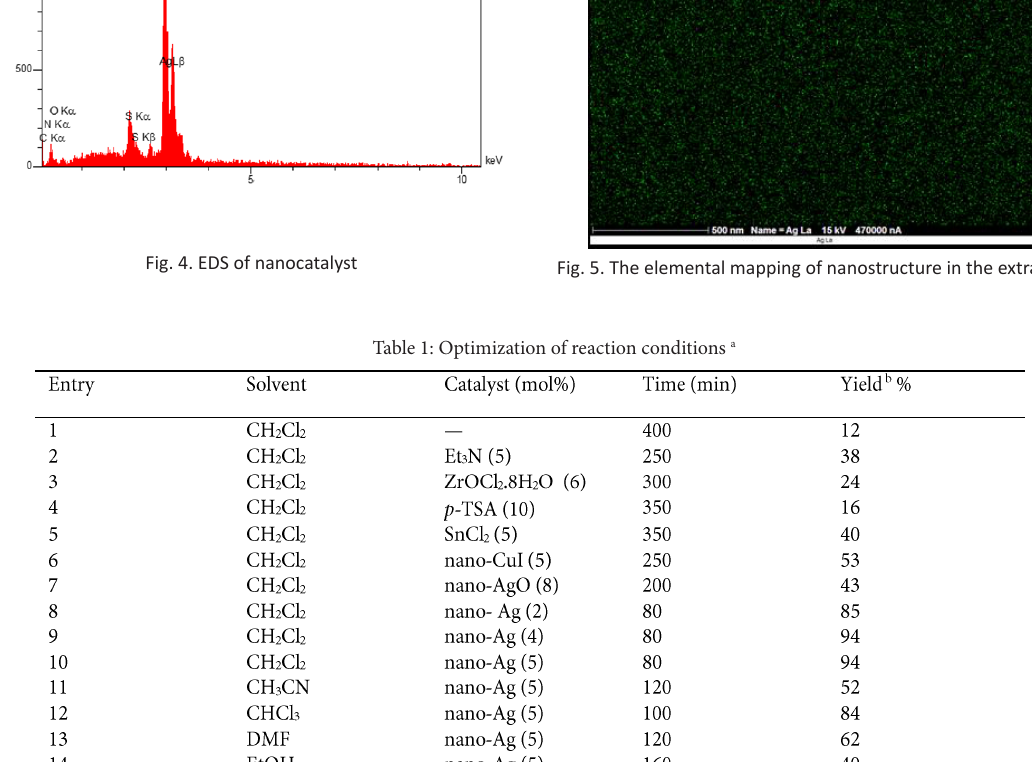
Fig. 5. The elemental mapping of nanostructure in the extract